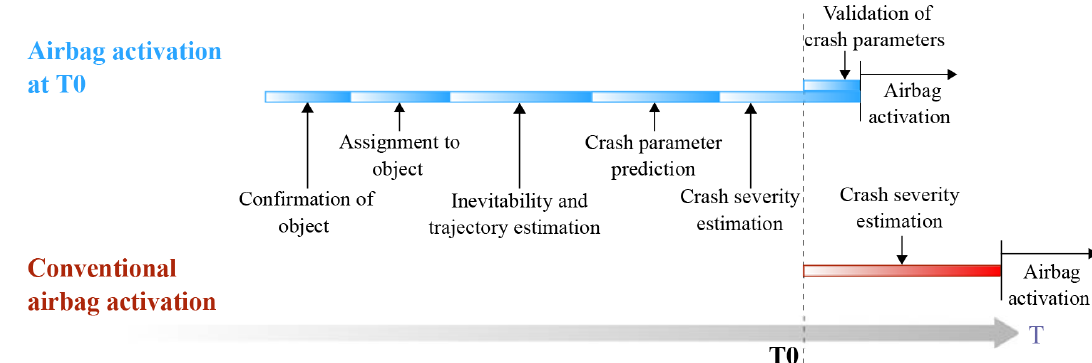
Figure 2. Predictive crash detection timeline.